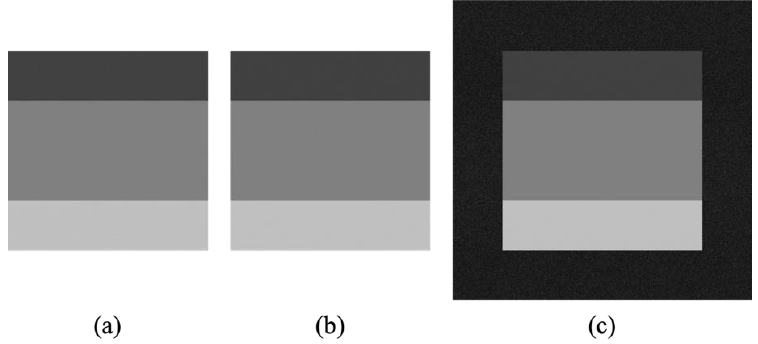
Figure 4. Reconstructed images from holograms calculated by ( a ) GS algorithm; ( b ) Fienup algorithm; and ( c ) ‘Fienup with don’t-care’ (FiDOC) algorithm, after 200 iterations.